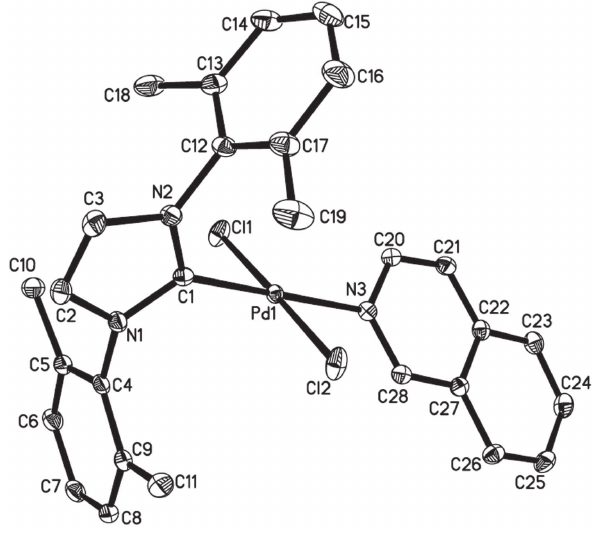
Table 1: Data collection and handling.